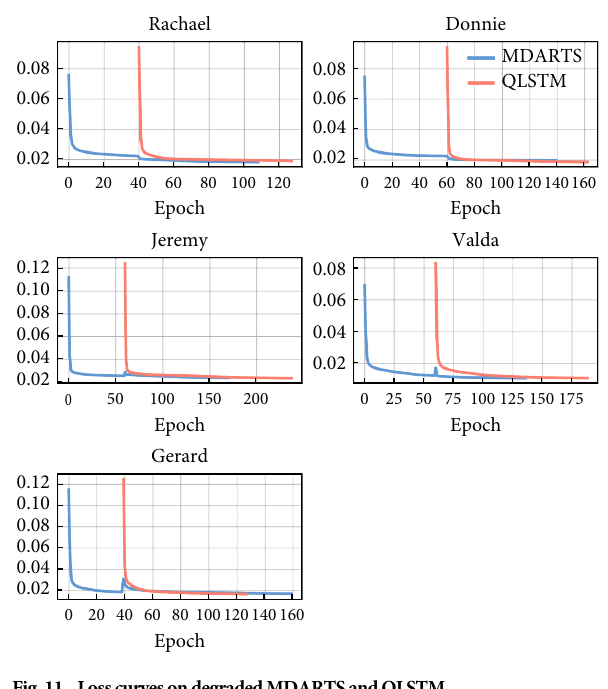
Fig. 11 Loss curves on degraded MDARTS and QLSTM.